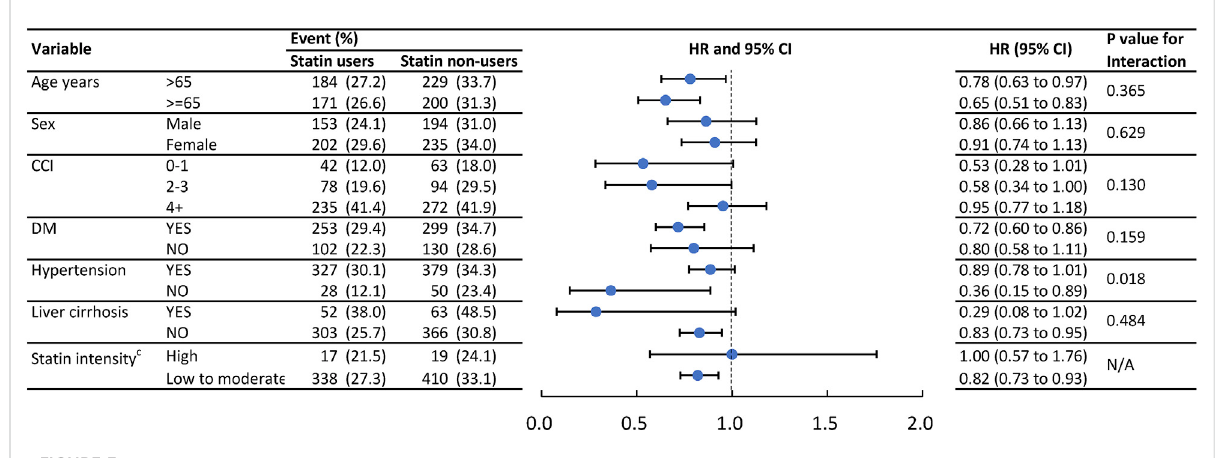
FIGURE 3 Event numbers and hazard ratios of the infection admissions between statin users and statin non-